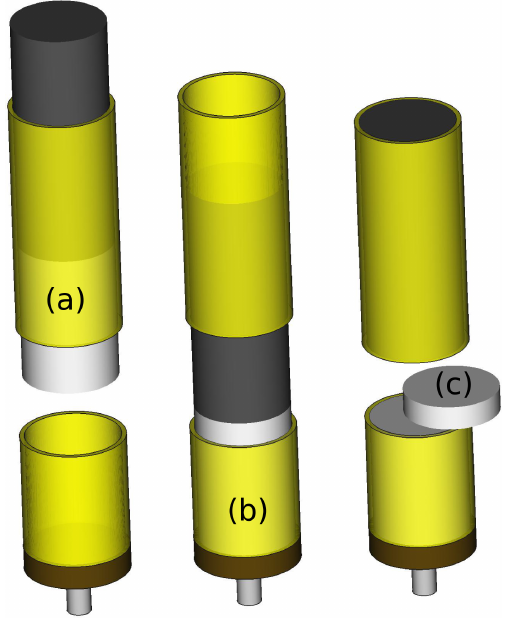
Figure 5. Illustration of the micro-CT sampling kit, with the sam- ple holder in yellow, the piston in black and the snow sample in white. Panel (a) presents the manufactured micro-CT sampling kit with the piston imitation (35mm depth) to retrieve the snow sam- ple. Panel (b) illustrates the snow sample transfer into the sampling holder (30mm depth), and panel (c) shows the process of cutting protruding snow with a spatula to create a flat sample surface.